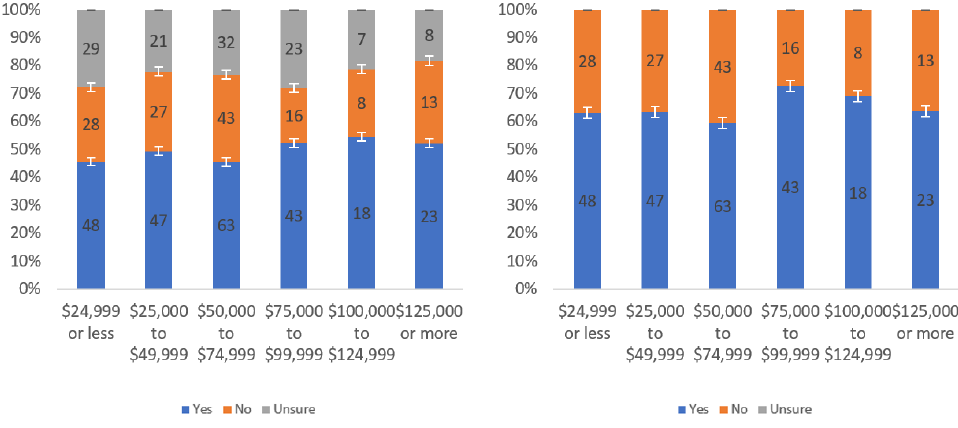
Figure 48. Responses regarding others’ willingness to review by income level including ( left ) and excluding ( right ) unsure responses.